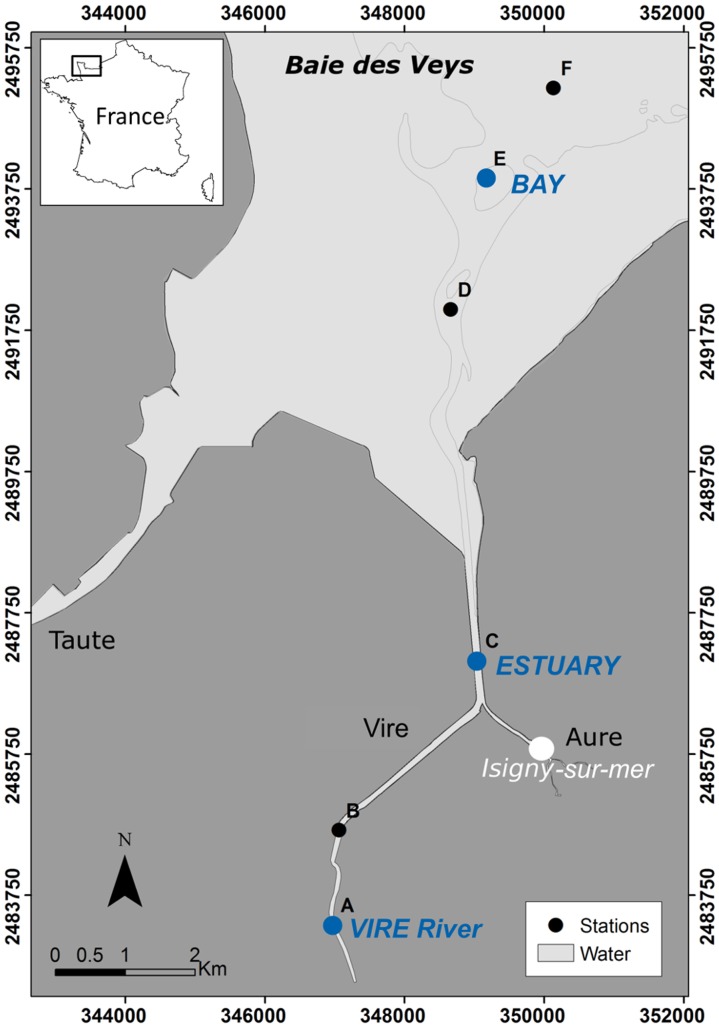
Map of the Vire River estuary (Baie des Veys) with location of the sampling stations (A–F).Blue dots indicate sampling points analyzed by both microscopy and clone library approaches (referred to as VIRE River, ESTUARY and BAY). Lambert II coordinates system.